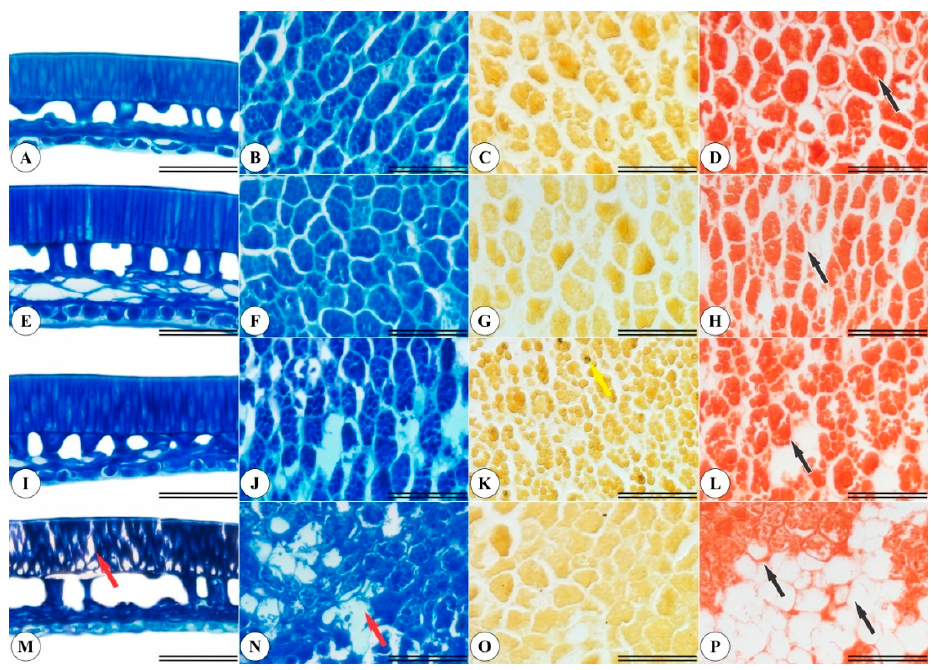
Figure 2. Pterodon pubescens radiographic seed images and 3D ( A , B ) yellow seeds, ( C , D ) light brown seeds, ( E , F ) dark brown seeds and ( G , H ) black seeds.